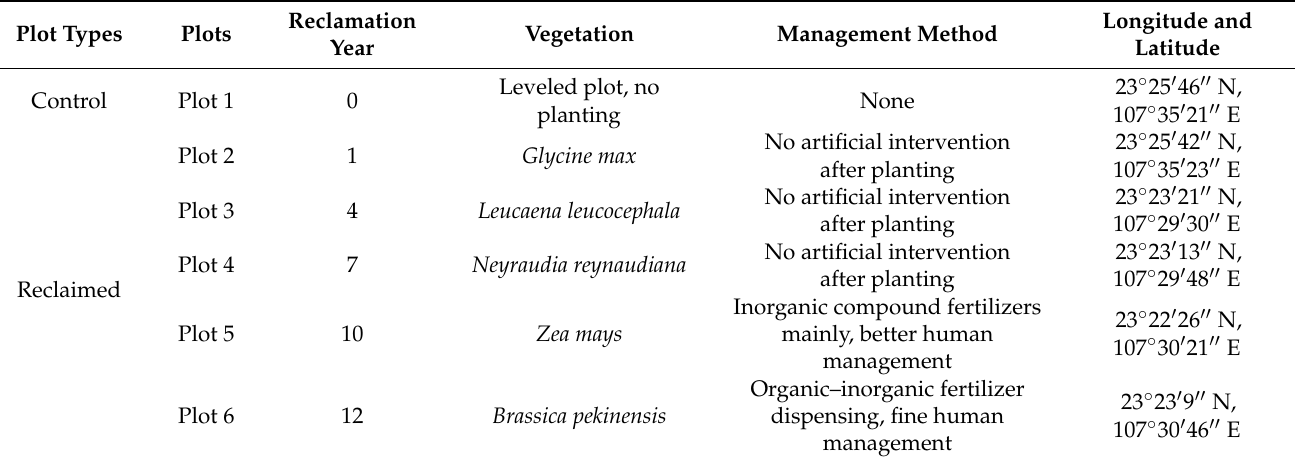
Table 1. Summary of the